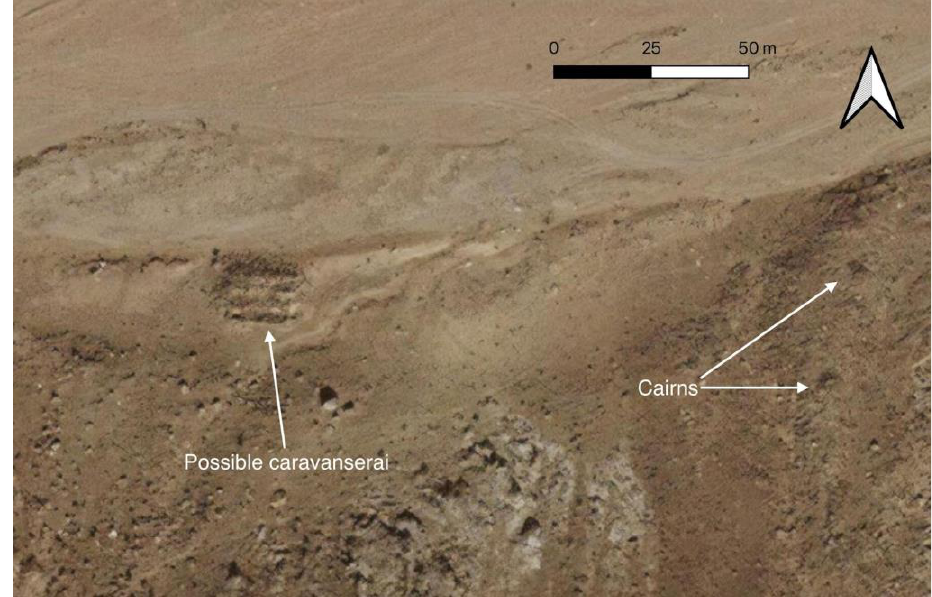
Figure 8. Satellite image of possible caravanserai site and nearby cairns. Source: Google Earth.